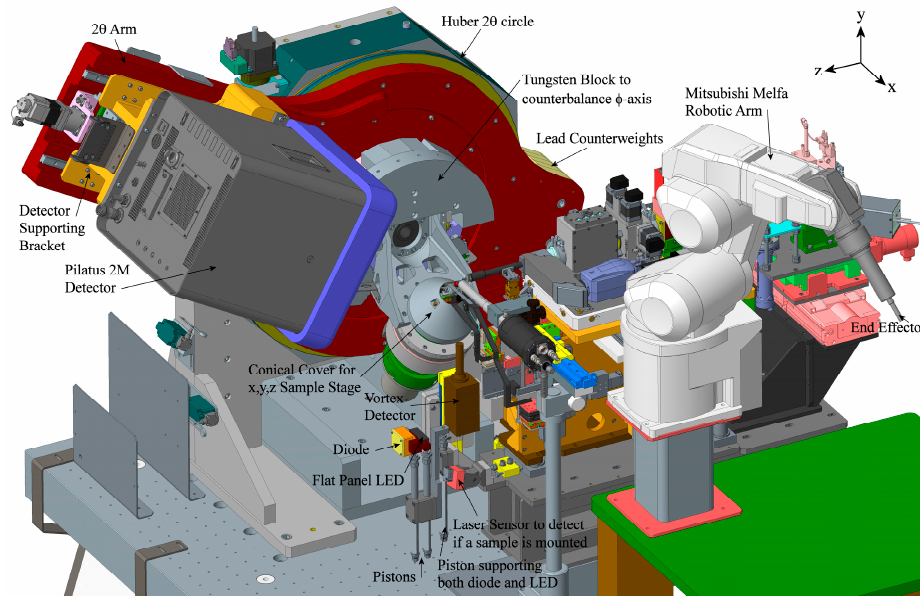
Figure 1. A general view of the complete end-station. The Dewar and the sample trays have been omitted for clarity. The indicated coordinate system is from the Diamond Light Source engineering standards and is used to define the sense of travel of the linear stages. The rotary stages of the diffractometer move in a positive sense when they are rotated clockwise as viewed from the front of the instrument. The diffractometer is depicted with 2 θ = 30°, ω = 0°, φ = 0° and with a detector distance of 500 mm (i.e., the distance between the detector sensor chips and the sample position).